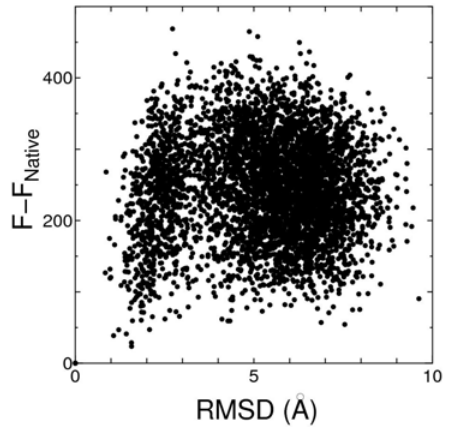
plotted against the RMSD from the native structure for all the Figure 3. Left: F  F Native seven proteins in the 4state_reduced decoy set. Right: R plotted against Q for all the seven proteins in the 4state_reduced decoy set. The three straight lines drawn represent Q =0, R =0, and Q + R =0,